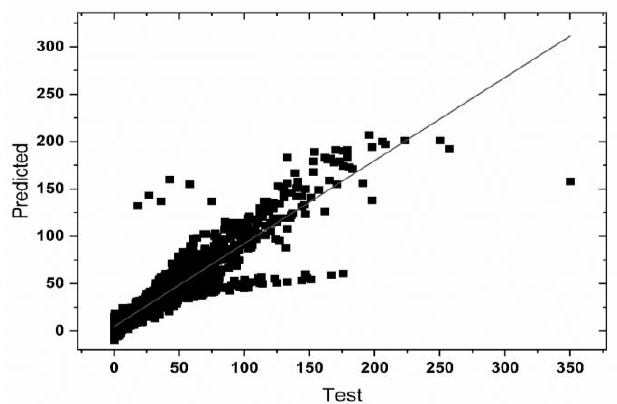
Figure 2. Plot of multiple linear regression ML model prediction for test data compared with the actual values.